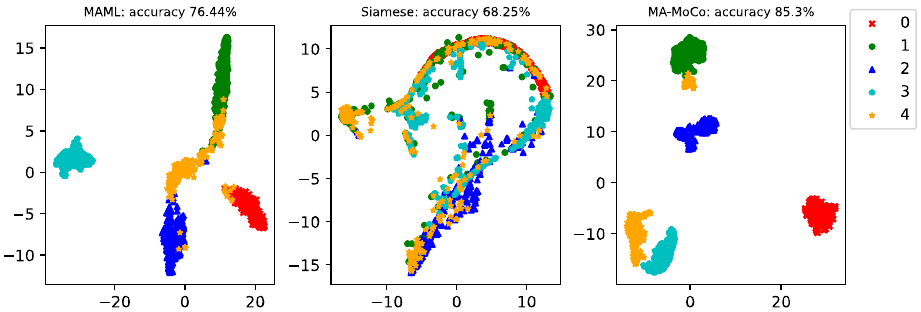
Figure 9. A 5-way 1-shot diagnosis of the generator bearing data when the training set of each class has only 20 fault samples.